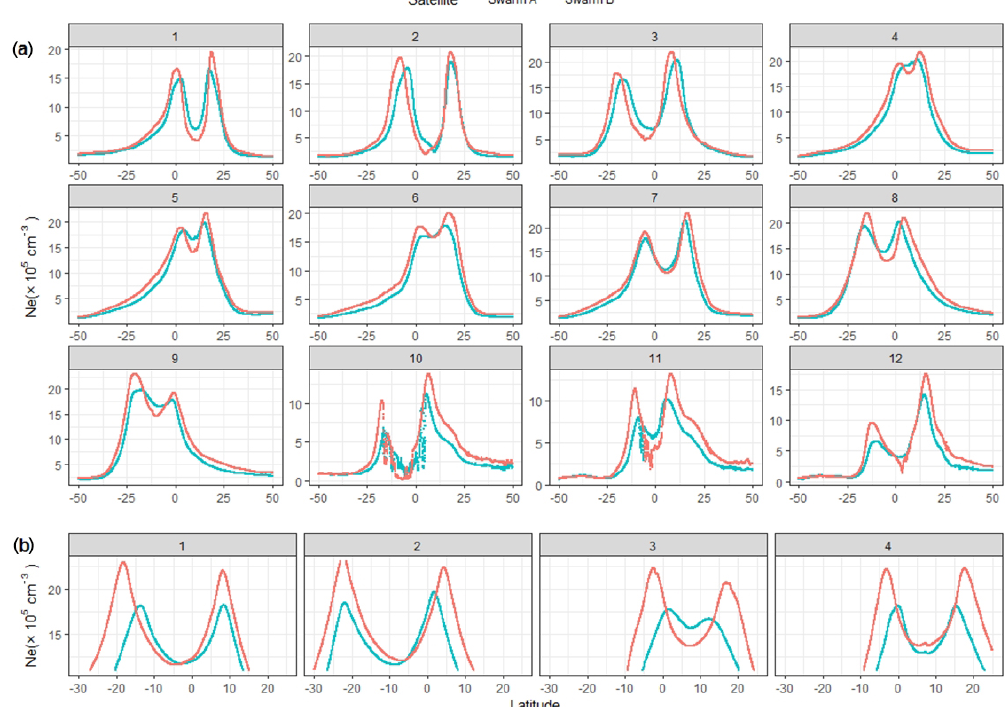
Figure 5. Morphology of stratification examples from different LTs. (a) Morphology of nighttime stratification from different LTs: pan- els (1) – (3) are from 12 February 2014 at 19:20LT, panels (4) – (9) are from 28 February 2014 at 17:50LT, and panels (10) – (12) are from 12 June 2014 at 21:00LT. (b) Typical morphology of daytime stratification: panels (1) – (2) are from 22 April 2014 at 13:40LT, panel (3) is from 22 March 2014 at 16:00LT, and panel (4) is from 20 March 2014 at about 16:20LT.